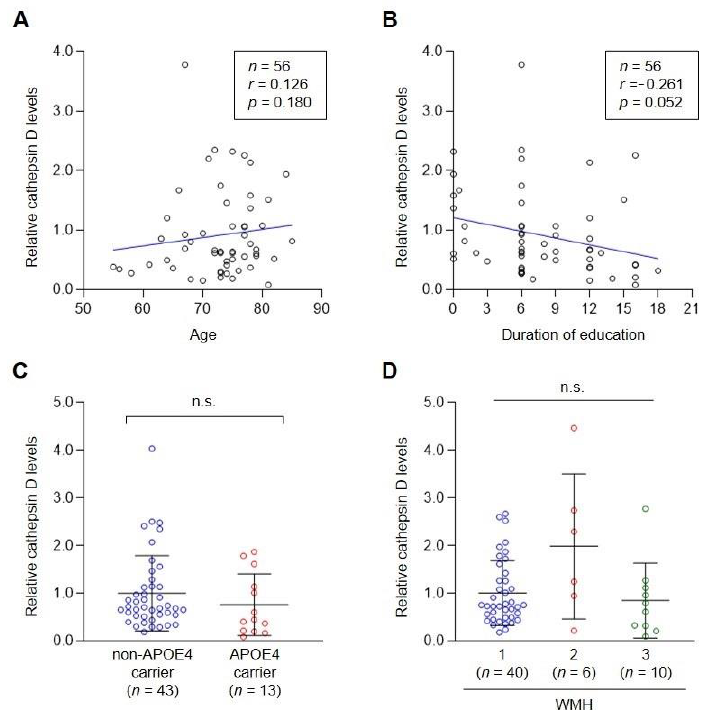
Figure 3. The level of plasma cathepsin D did not correlate with age, duration of education, the pres- ence of the APOE ε 4 allele, or WMH scores. ( A – D ) Correlations of plasma cathepsin D levels with age ( A ), duration of education ( B ), presence of the APOE4 gene ( C ), and WMH scores ( D ) were analyzed. Each dot indicates the cathepsin D level of each control or patient plasma. ( A , B ) Pearson correlation coefficient (r) and p -value of linear regression are shown in each panel. ( C , D ) Mean ± SD was illustrated as a horizontal line in each group. n.s., not significant (Mann–Whitney U test for ( C ) or Kruskal–Willis test for ( D